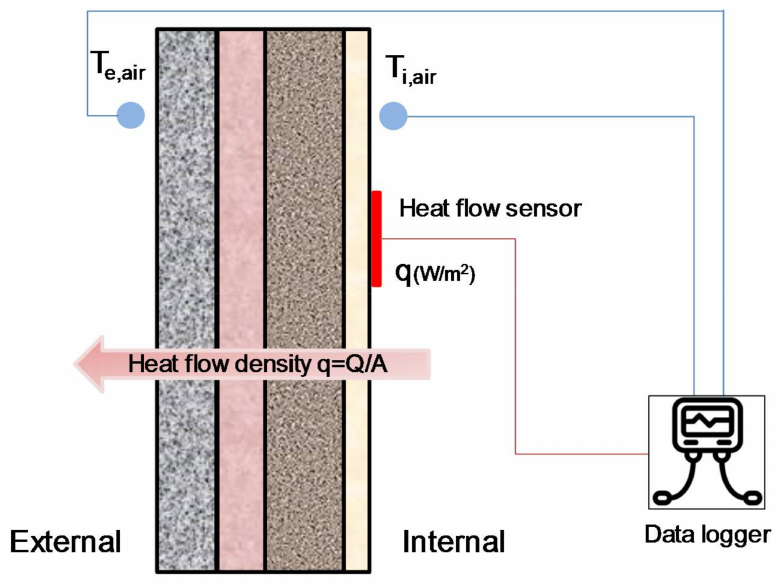
Figure 2. ISO 9869-1:2014—Part 1: HFM